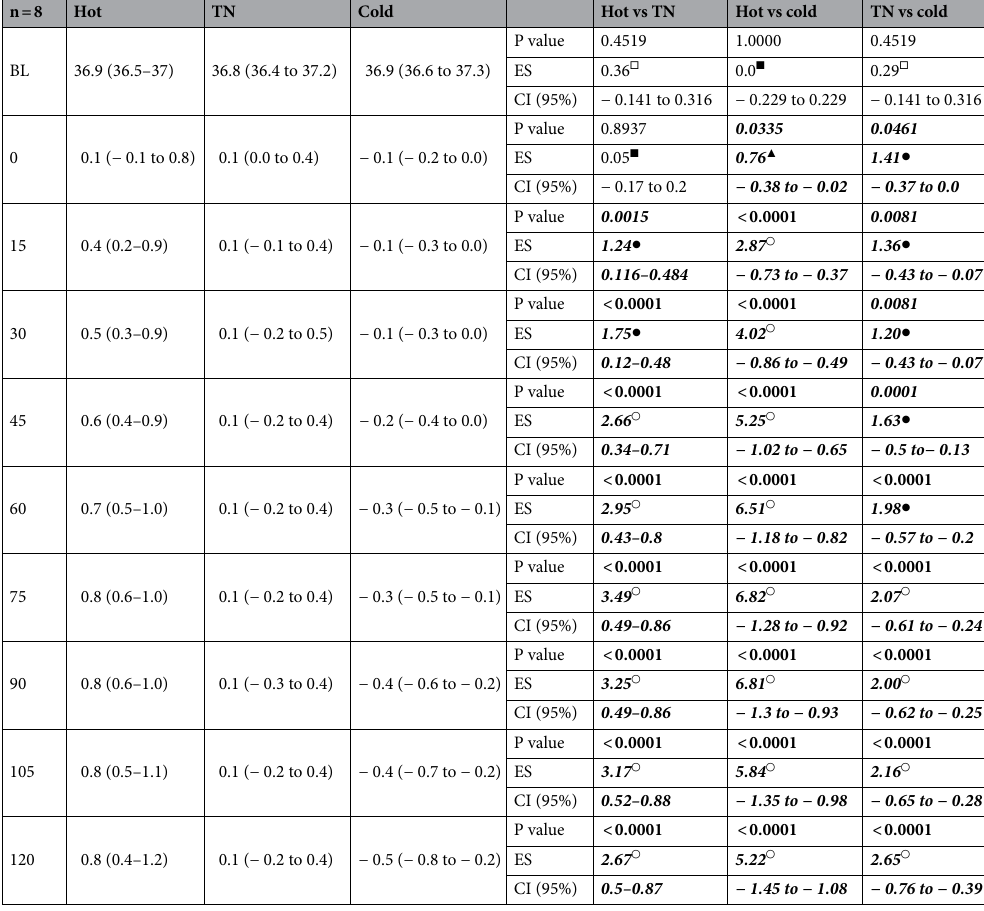
Table 1. Mean differences in Trec (°C) compared to baseline and between condition interactions. Values expressed as mean (range). Raw BL values presented for context. Bold and italic text denotes a significant finding. Symbols are used to denote the ES (e.g. ■ ‘trivial’, □ ‘small’, ▲ ‘moderate’, ● ‘large’, ○ ‘very